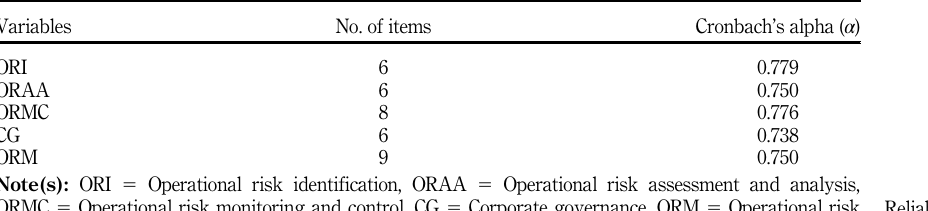
Table 1. Reliability analysis